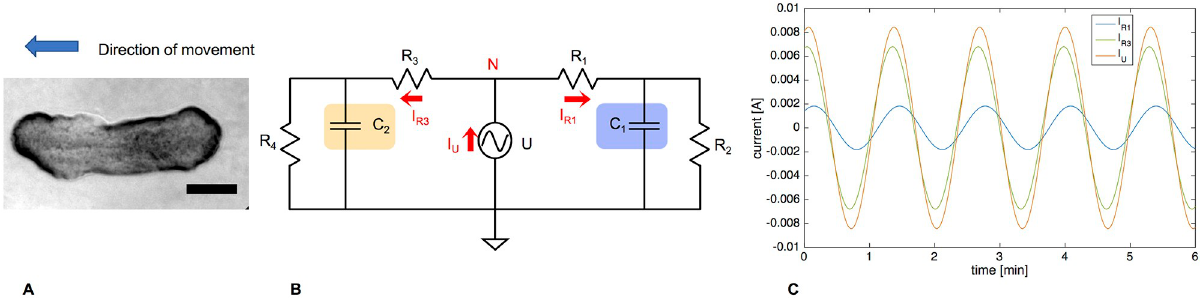
Fig 17. Case 2: Polarized, migrating plasmodium. A) Migrating, polarized microplasmodium. Scale bar = 50 μ m. B) Symmetrical model circuit for a motile microplasmodium. C = capacitors, R = resistors, U = voltage source, I = current. C) Current flowing through the right side as taken at R 1 (blue) and the left side as taken at R 3 (green), and current flowing through the voltage source ( I U ,